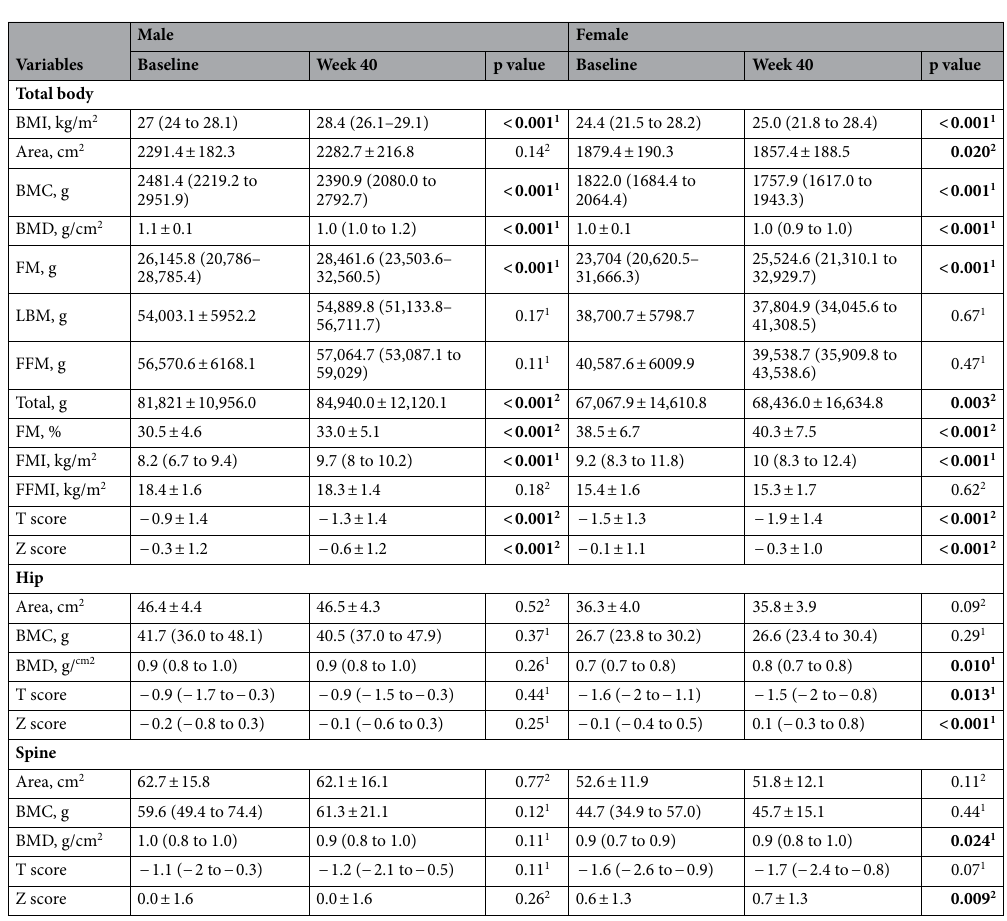
Table 4. Body composition assessed by DXA at baseline and week 40. BMI body mass index, BMC bone mineral content, BMD bone mineral density, FM fat mass, LB M lean body mass, FFM fat-free mass, FMI